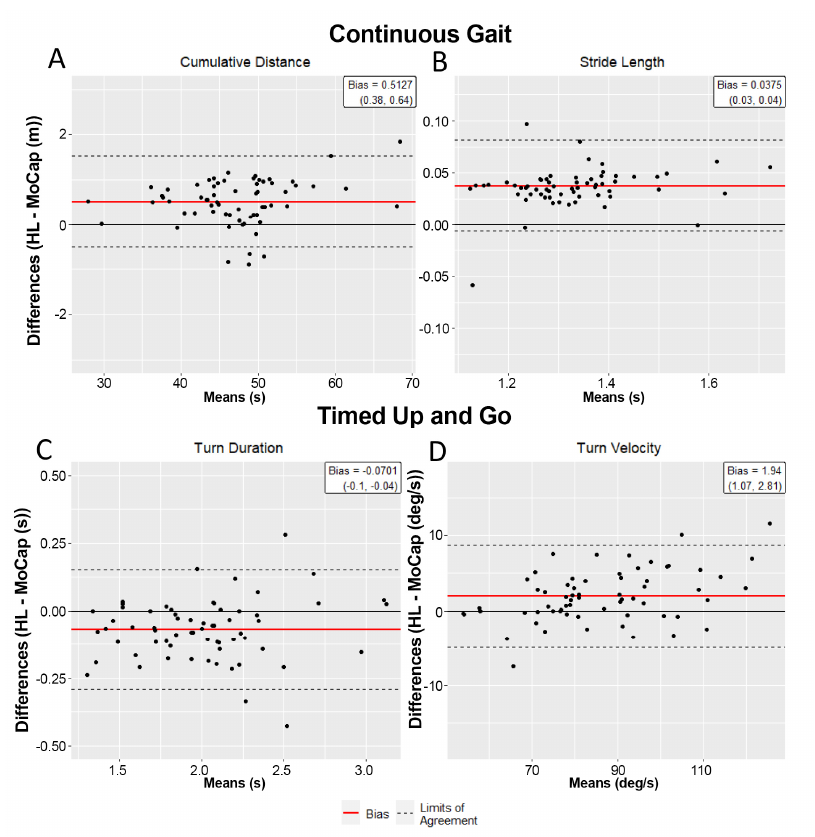
Figure 3. Bland–Altman plots for continuous walking ( A , B ) and TUG ( C , D ) metrics. ( A ) Average cumulative distances over the 60 s walk for the HL2 and MoCap were 47.46 (7.26) and 46.95 (7.15) m, respectively, with the average bias (HL2-MoCap) of 0.51 m and LOA of ( − 0.50, 1.52) m. ( B ) For average stride length, the average bias was 0.04 m with LOA of ( − 0.01, 0.08) m. ( C ) For turn duration, the average bias of the HL2 was − 0.07 s with LOA of ( − 0.29, 0.15) s. ( D ) For turn velocity, the average bias was 1.94 deg/sec with LOA of ( − 4.89, 8.77)